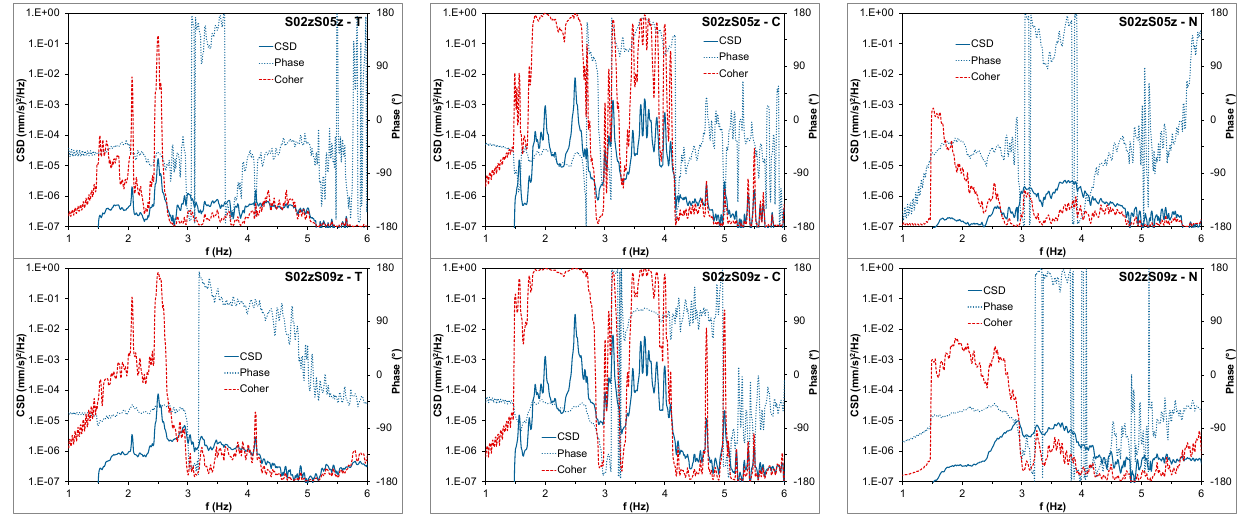
Figure 15. Circus: CSDs S02z-S05z and S02z-S09z for the three time intervals. In Figure 16, the spectral ratios between each horizontal and the vertical component are plotted for S02, S05, and S09. In almost all cases, the maximum ratio is at 1.55 Hz, with values higher for the y direction. This frequency is probably related to the soil